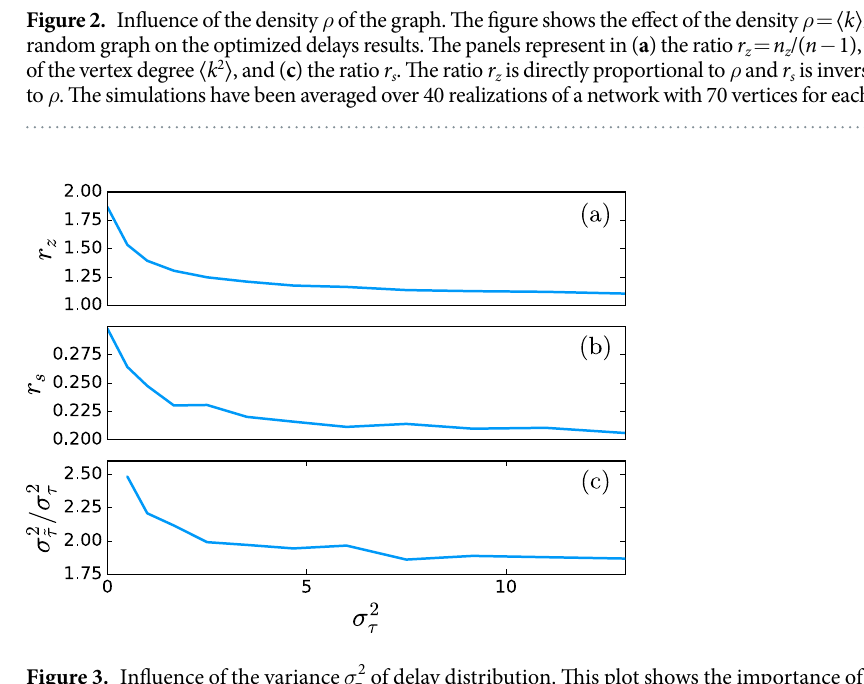
time delays, such relations vanish. However, the simplex algorithm is still capable of finding a lower total sum of time delays, which may be of interest. While real valued time delays are more general, integer valued time delays are very relevant when it comes to the numerical integration of differential equations. For the numerical algorithms involving finite and constant step size, the values of the time delays, that may have been issued from a continuous distribution, have to be discretized and rounded to the closest integer multiple of the time step. The set of continuous time delays is transformed into a new set o commensurable time delays that will give much better results from the point of view of the optimization. The previous examples focus on the properties of the networks and delay distribution and do not involve any specific dynamical system. We present an application where a network of Kuramoto phase oscillators is coupled with time delays 4 . The phase oscillator model is a very simple abstraction of the essential properties of limit cycle oscillators. We can use this model to test our optimization method on a complex network of simple dynamical systems. The setup consists of a unidirectional Erdös-Rényi random network with average degree d , where the vertices represent Kuramoto oscillators with an identical intrinsic frequency ω . The edges of the network repre- sent a time delayed interaction chosen randomly according to a statistical distribution. The coupled delay differ- ential equation can be written as